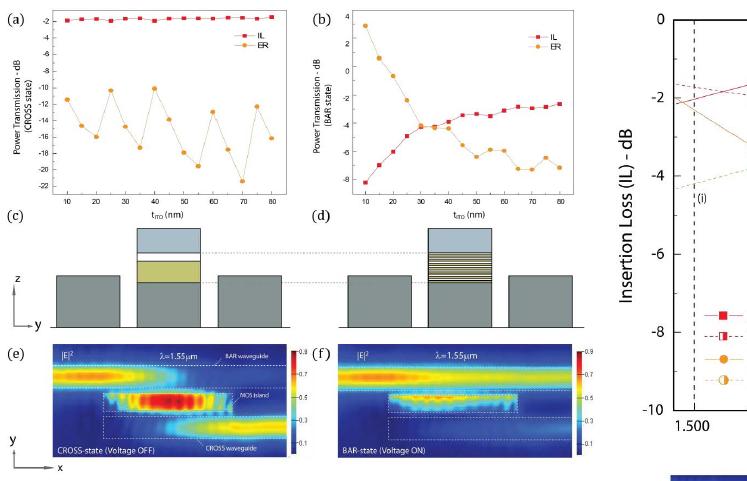
Figure 3: Power transmission as a function of ITO thickness ( t ITO ) at (a) the CROSS state, and (b) the BAR state, respectively (normal- ized to input power). (c) and (d) Cross-section schematic (not to scale) of single-layer and multi-layer ITO design at MOS island in the yz plane, respectively. (c) The original design schematic with one SiO 2 /ITO layer. (d) Metamaterial like design where the thick ITO layer is replaced with a multilayer design SiO 2 /ITO (2 nm/10 nm). Switching function for the plasmonic 2 × 2 electro-optic switch through voltage control is verified by showing electric field in- tensity profile distribution over the device in the xy plane at the middle of ITO layer, (e) electric field intensity for a TM input of the CROSS state ( V OFF ), and (f) BAR state ( V ON ). Device geometry parameters for 3D FDTD simulation: silicon core width = 160 nm, height = 300 nm, g = 100 nm, seven-bilayer stack: SiO 2 /ITO (1 nm/10 nm) layer, Al contact = 100 nm, and SOI waveguide buses: 450 nm × 250 nm, gap = 100 nm. λ = 1550 nm.